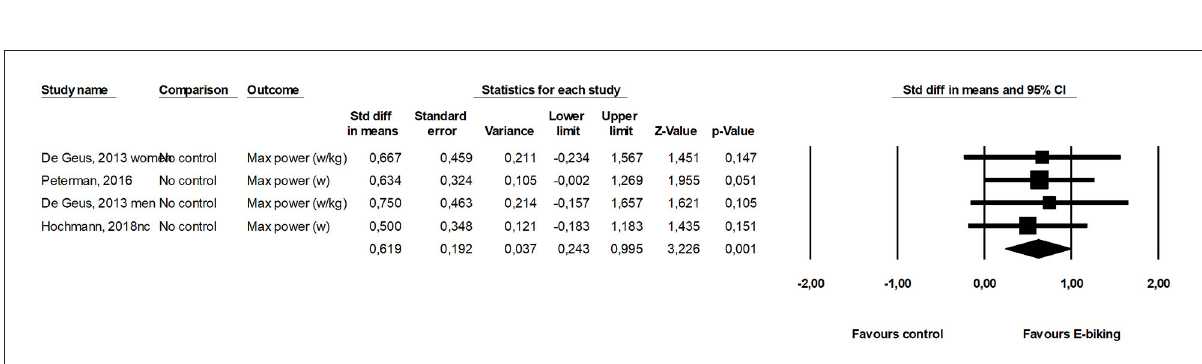
FIGURE3 Forest plot for the effect of E-cycling on maximal power output during